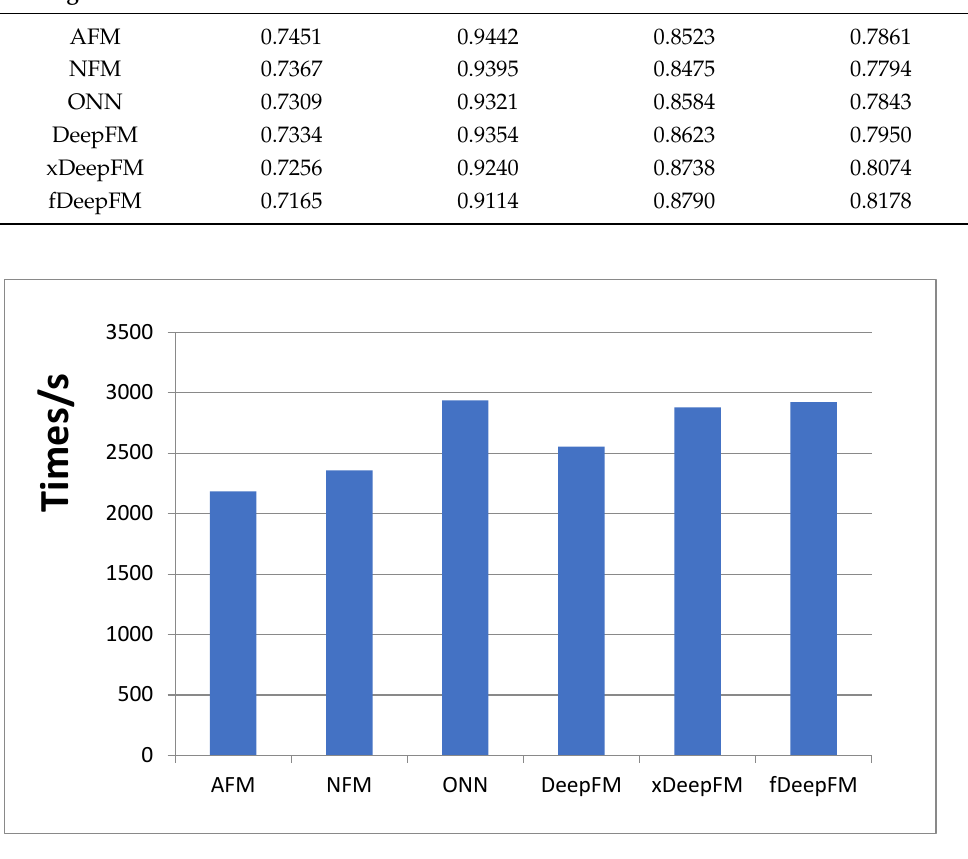
Figure 5. Comparison of training time. Table 2. Numerical comparison of evaluation indexes of the algorithm in Amazon data